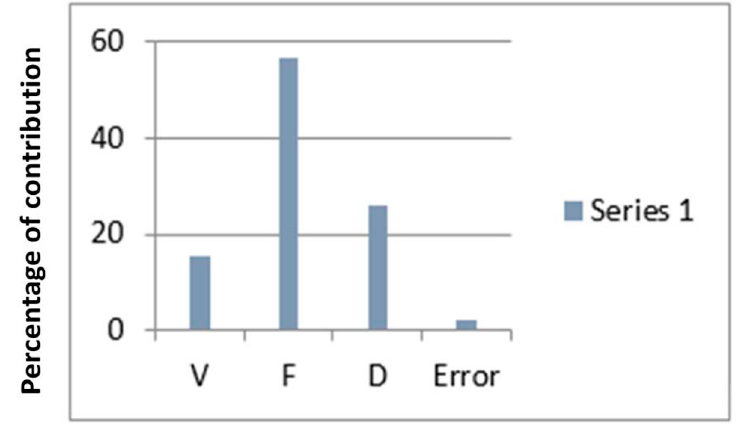
Figure 7. Graph for percentage of contribution of inputs for GRA technique. Table 11. Analysis of Variance for GRG